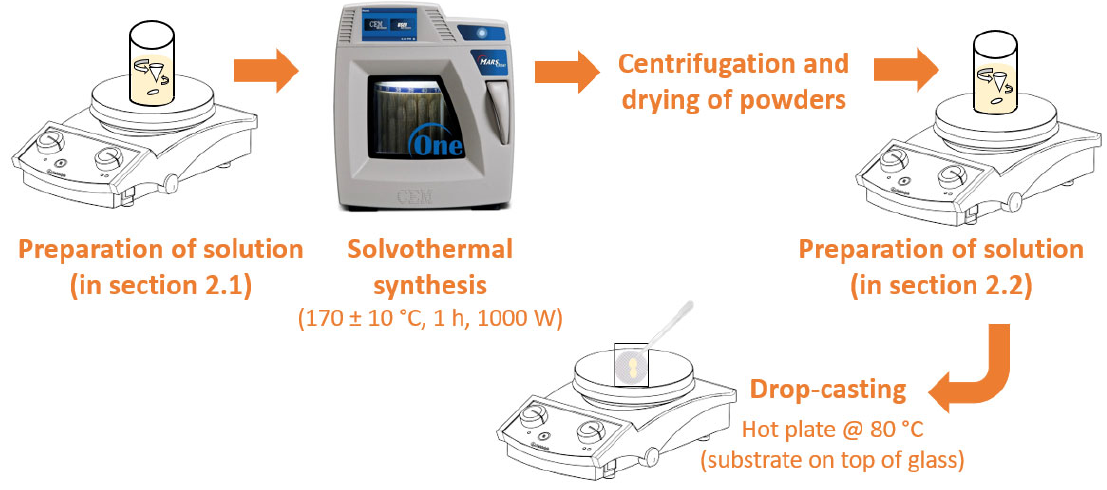
Figure 1. Schematic illustration for the synthesis of nanostructures and impregnation process.